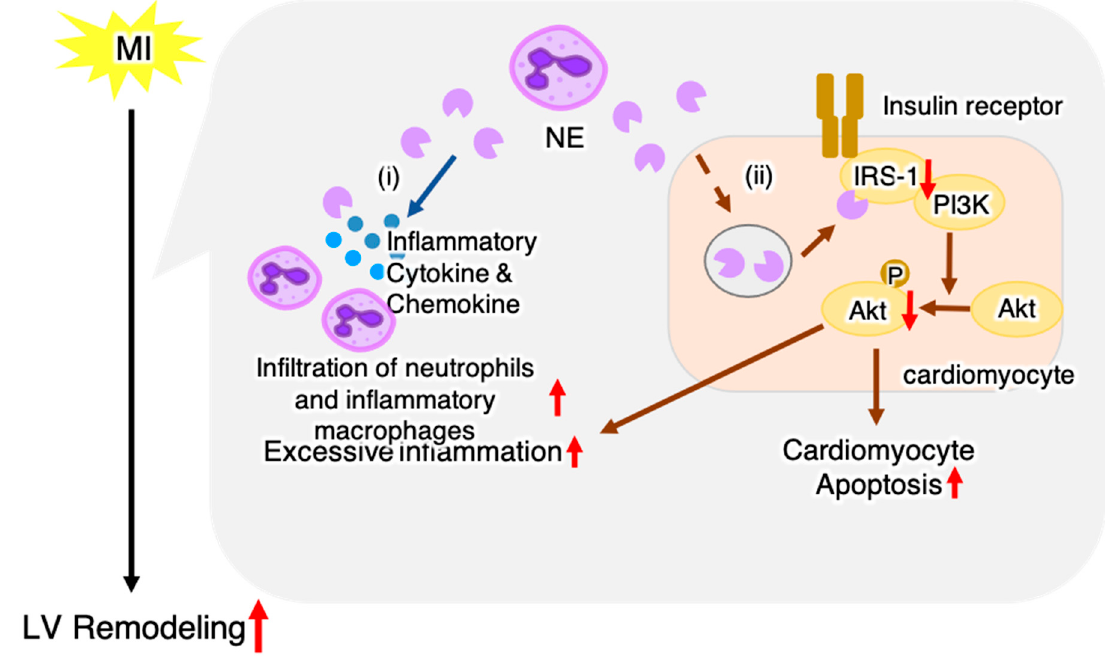
Figure 7. Schematic illustration showing a hypothetical mechanism of NE-mediated LV remodeling post-MI. Post-MI, NE-producing neutrophils infiltrate the heart; our data suggest that NE exacerbates LV remodeling through two pathways: ( i ) NE released from neutrophils induces excessive inflammation, and ( ii ) NE decreases Akt signaling via degradation of IRS-1 leading to cardiomyocyte apoptosis and excessive inflammation. The red arrow indicates the effect of